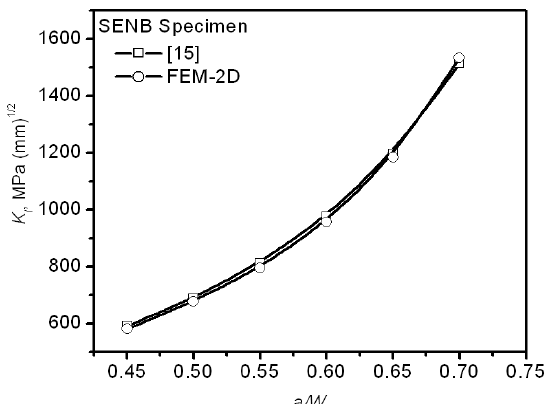
Figure 3: Variation of K vs. a/W obtained by Eq. (2) Ref [15] and 2D I